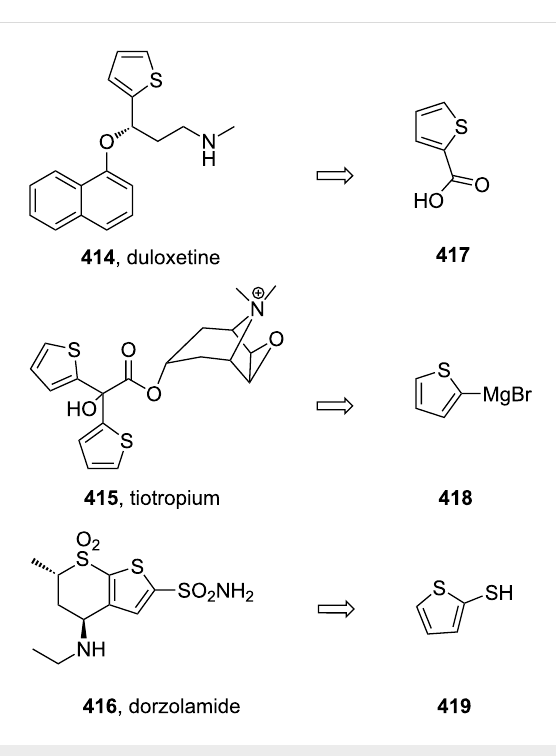
Figure 13: Access to simple thiophene-containing drugs.